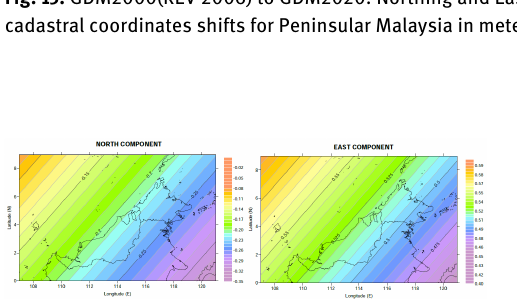
Fig. 16. GDM2000(REV 2006) to GDM2020: Northing and Easting mapping coordinates shifts for East Malaysia in